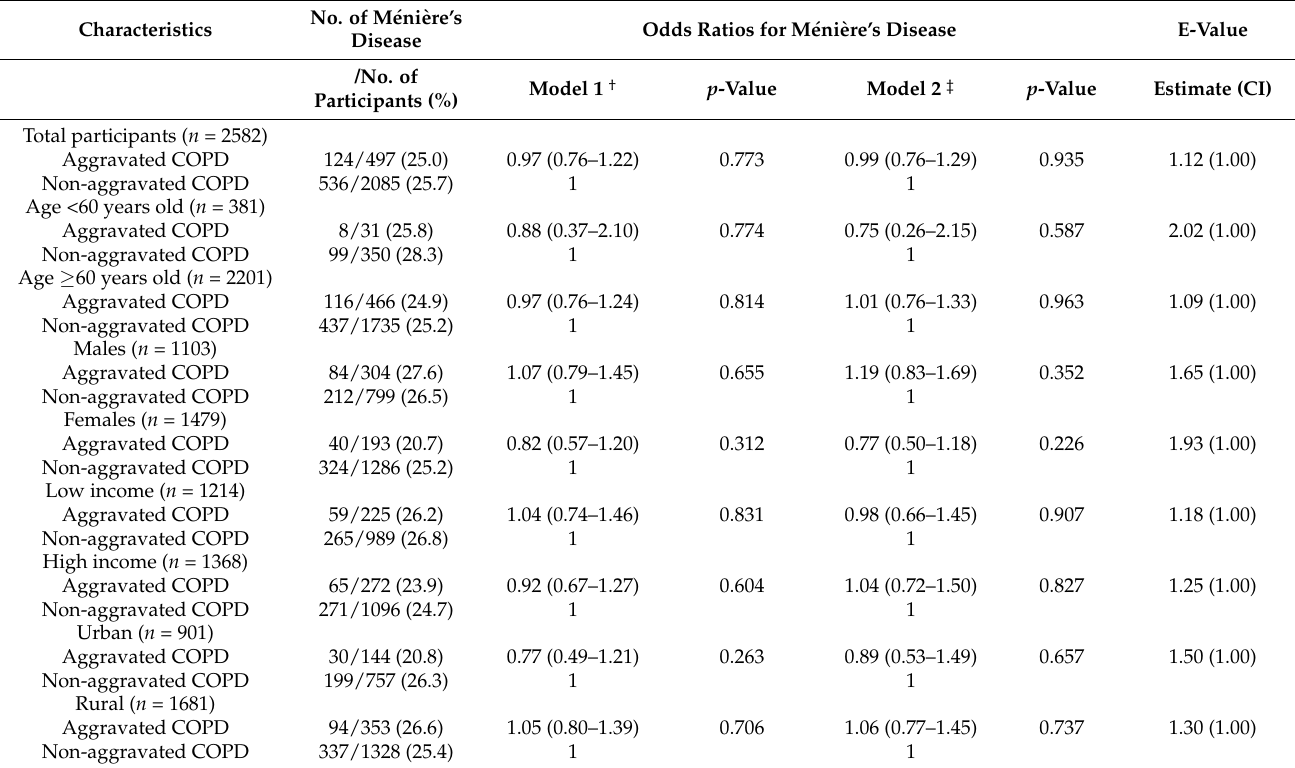
Table 3. Odds ratios (95% confidence intervals) of aggravated chronic obstructive pulmonary disease for M é ni è re’s disease with subgroup analyses according to age, sex, income, and region of residence in COPD